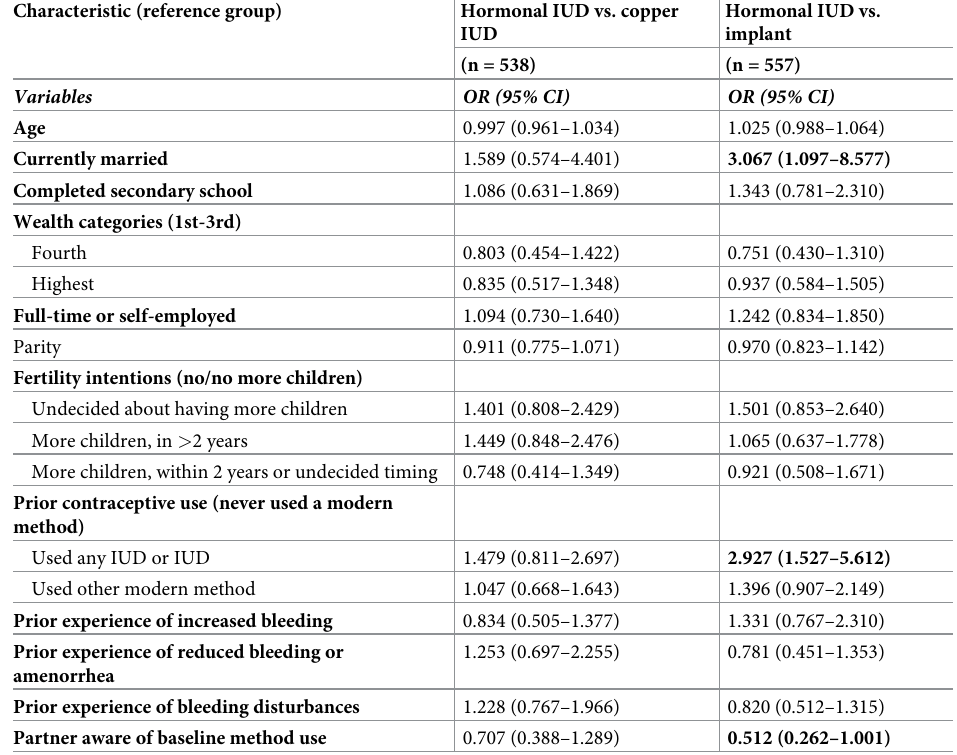
Table 3. Adjusted odds ratio estimates and 95% confidence interval from logistic regression analyses associated with choosing the hormonal IUD over other